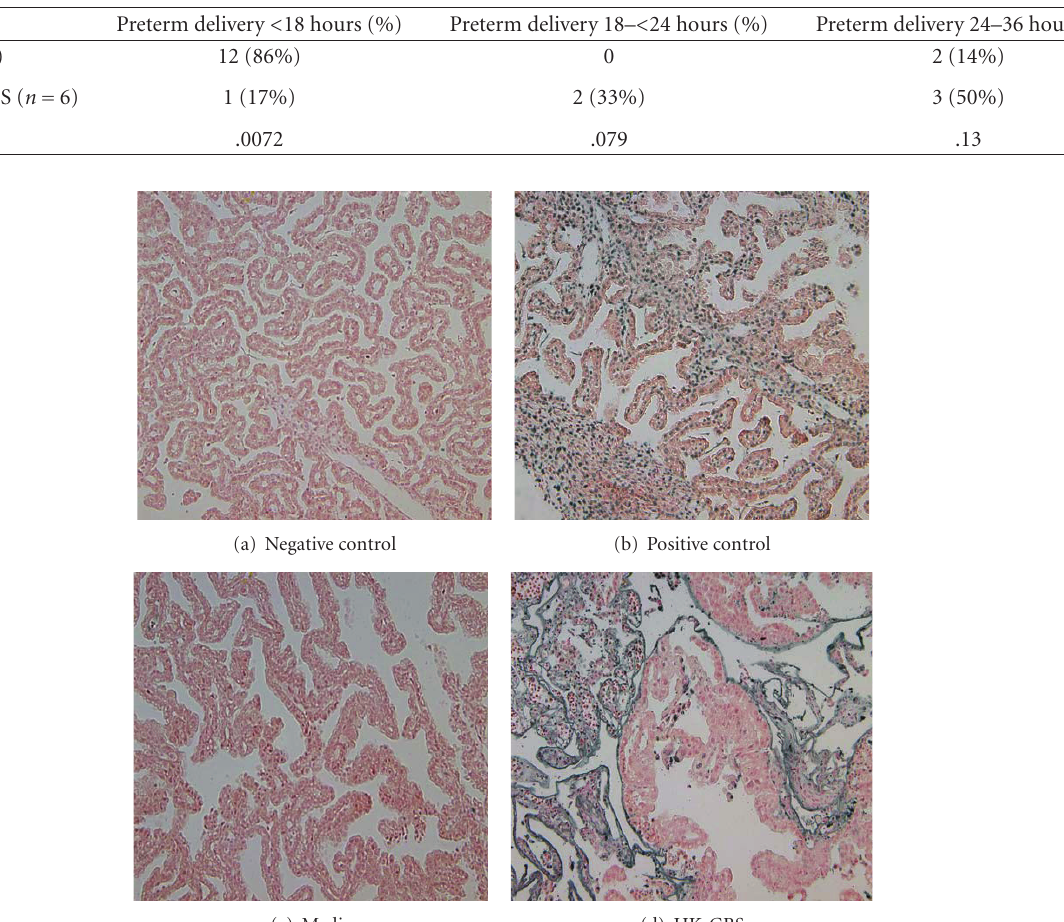
Table 1: Intraperitoneal HK-GBS injection leads to preterm delivery, and pretreatment with Z-VAD-FMK delays preterm delivery in mice . 10 9 heat killed GBS bacteria were injected intraperitoneally in day 14.5 pregnant CD-1 mice. Data from animals treated with HK-GBS without